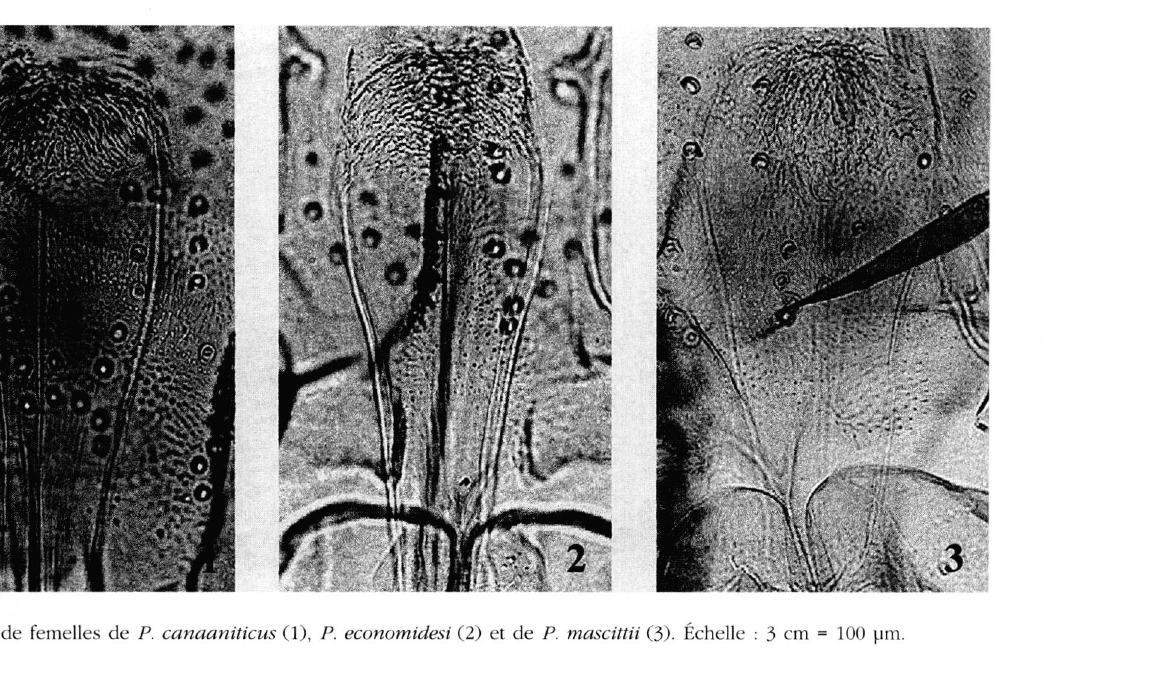
Fig. 2. - Pharynx de femelles de P. canaaniticus (1), P. economidesi (2) et de P. mascittii (3). Échelle : 3 cm = 100